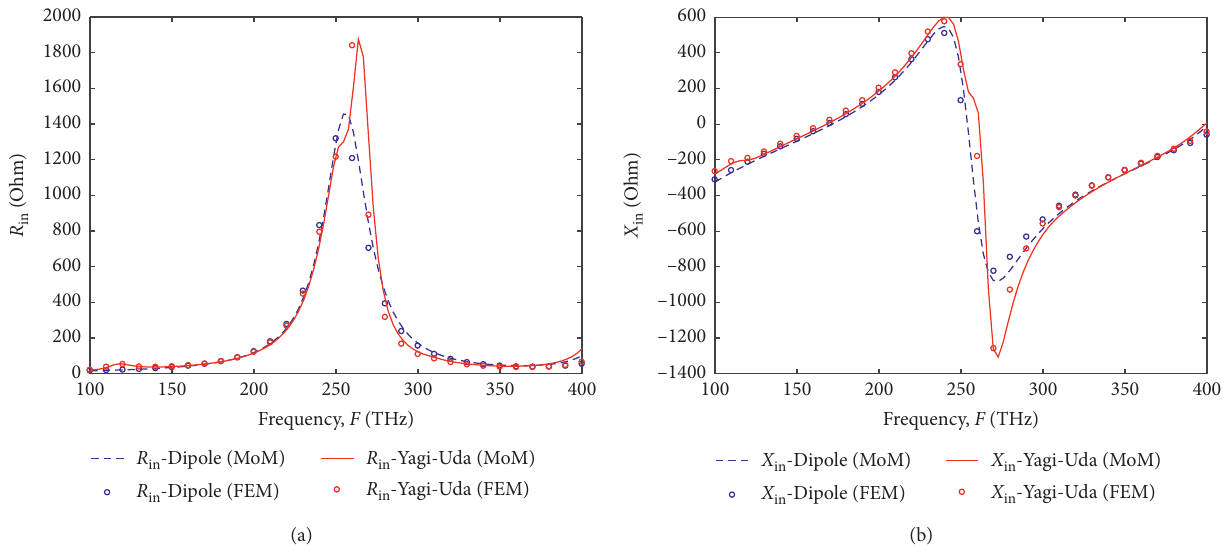
Figure 3: Input impedance of YU array and nanodipole: (a) R 460nm, h 1 � h 2 � h 3 � 250nm, d h � d 1 � d 2 � d 3 � 100nm and a 1 � a 2 � a 3 � a h � a r �